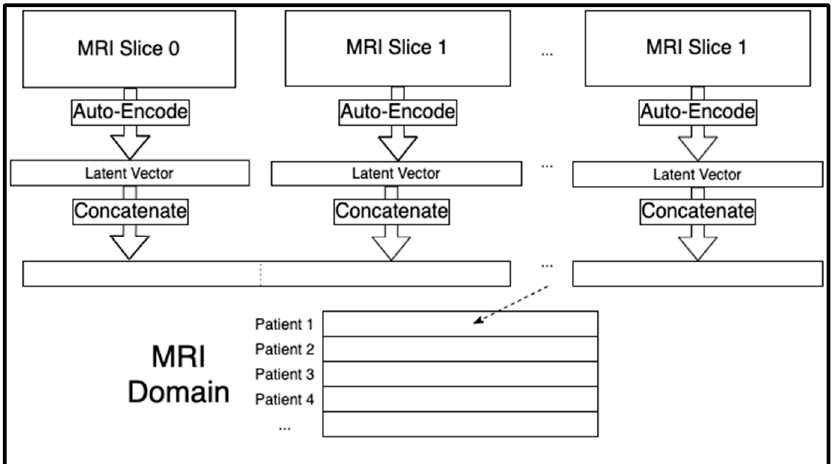
Figure 1. Creation of the MRI domain from the MRI slice sequences using the trained convolutional autoencoders. A separate autoencoder was trained for each MRI slice, and the latent space was concatenated for each person to create a row specific to that individual.